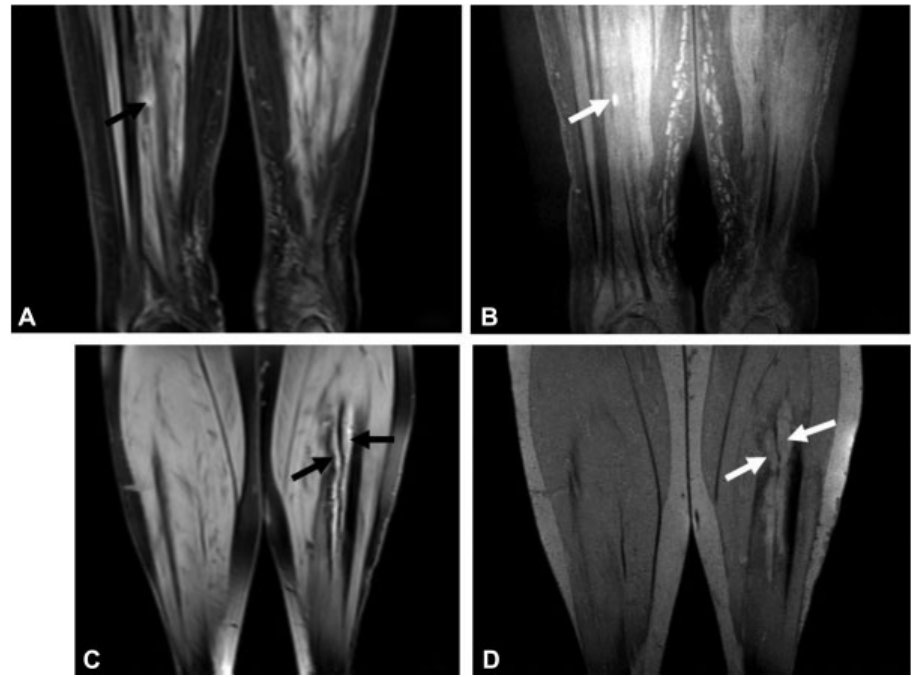
Fig. 2 A 57-year-old man ( patient 3 , ► Table 2 ) with a small peripheral calf vein thrombosis of the right leg, shown on the MRDTI sequence ( A ) ( blackarrow ) and TSE-SPAIR sequence ( B ) ( white arrow ). A 70-year-old women ( patient 7 , ► Table2 ) with thrombosis in the calf veins, shown on the MRDTI sequence ( C ) ( black arrows ) and TSE-SPAIR sequence ( D ) ( white arrows ).